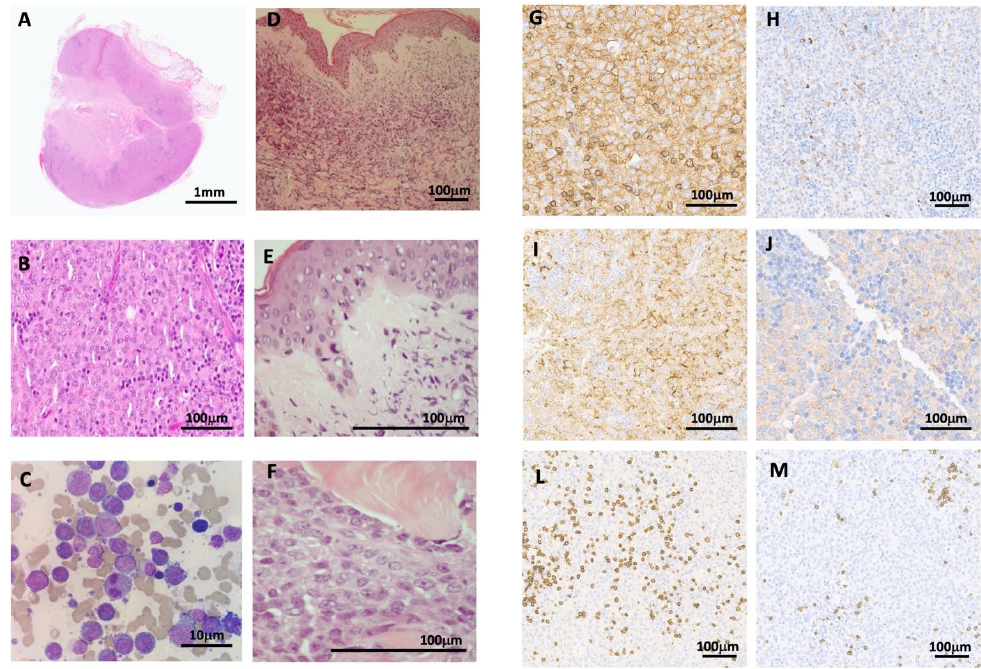
Figure 2. Laboratory findings. ( A , B ) Lymph node biopsy: structural changes with diffuse prolifera- tion. The cells are large with large nuclei and evident nucleoli. The cytoplasm is vast and eosino-